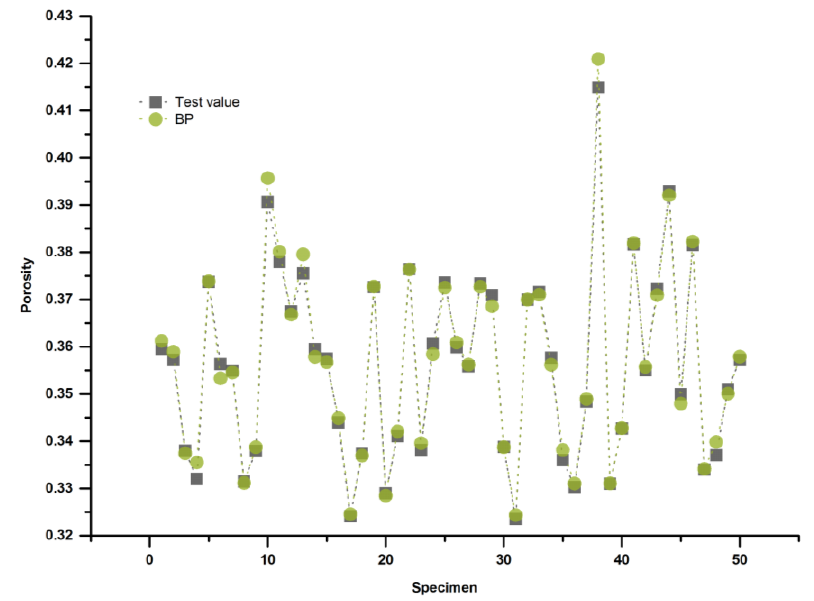
Figure 8. Porosity comparison among testing value and predicted value for Gradation-16.